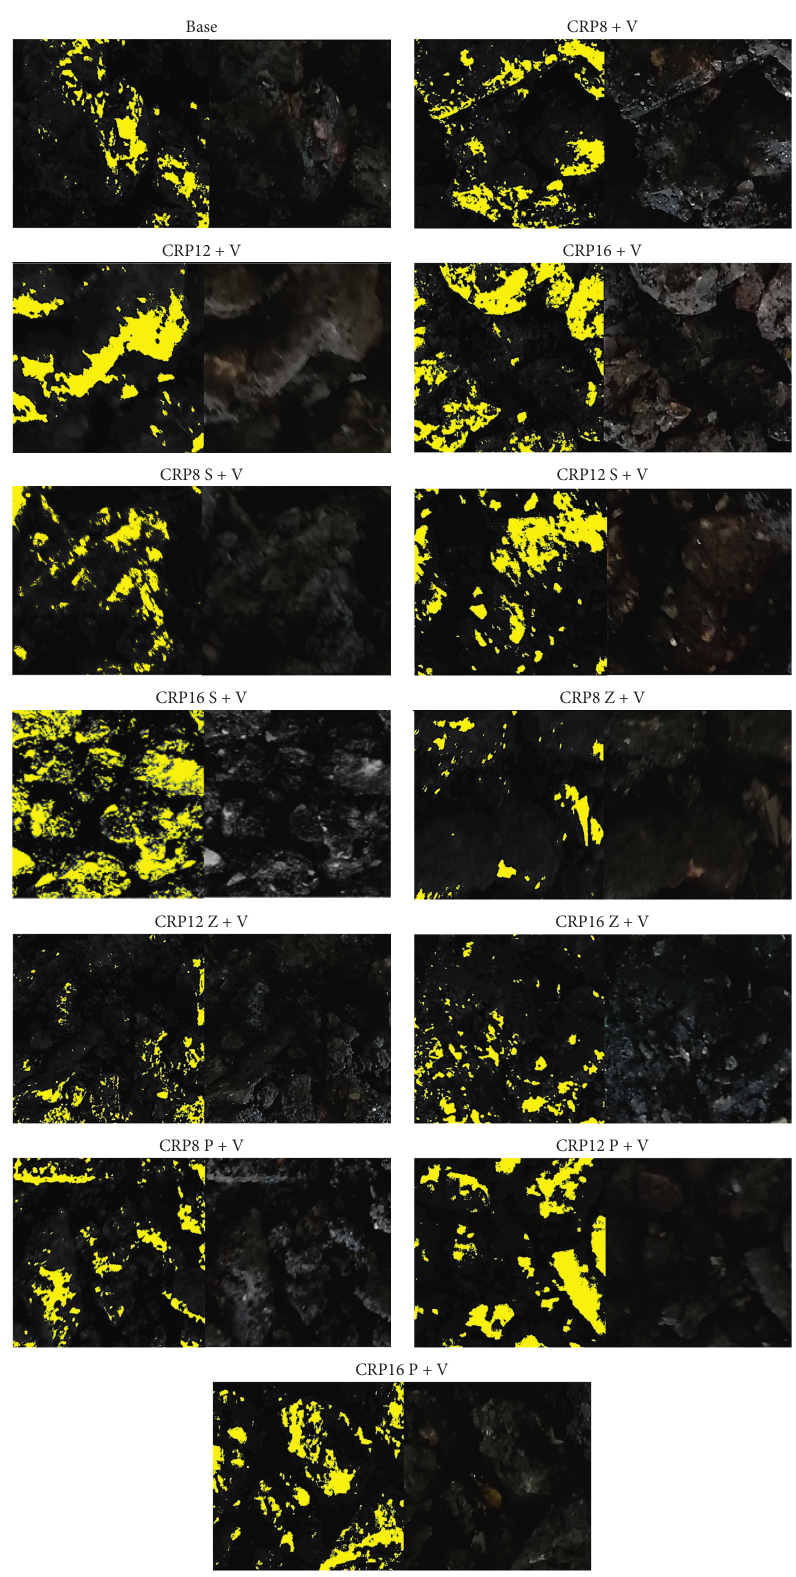
Figure 3: The image processing of samples after the boiling water